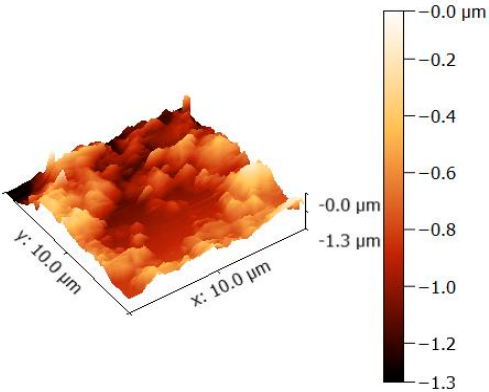
Figure 3. Atomic Force Microscopy (AFM) analysis of GO-Ag nanocomposites.